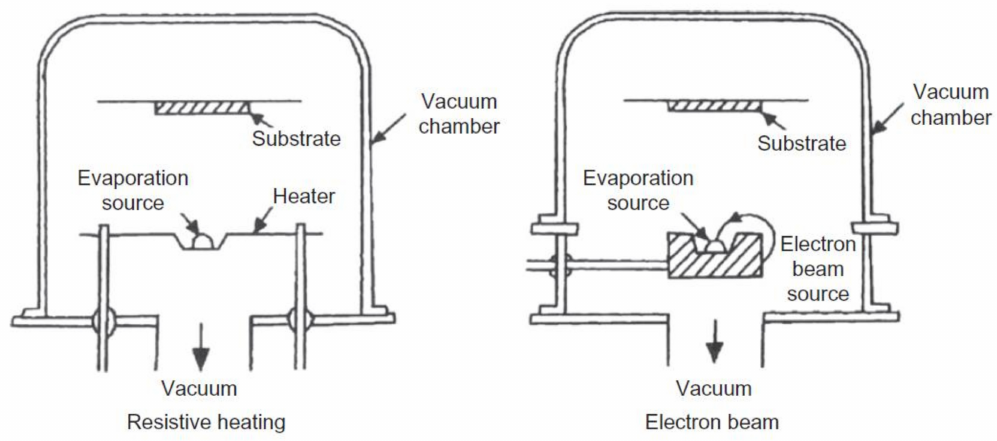
Figure 10. Typical thermal evaporation system representing resistive heating and electron beam heating. Reprinted with permission [75]; 2012,